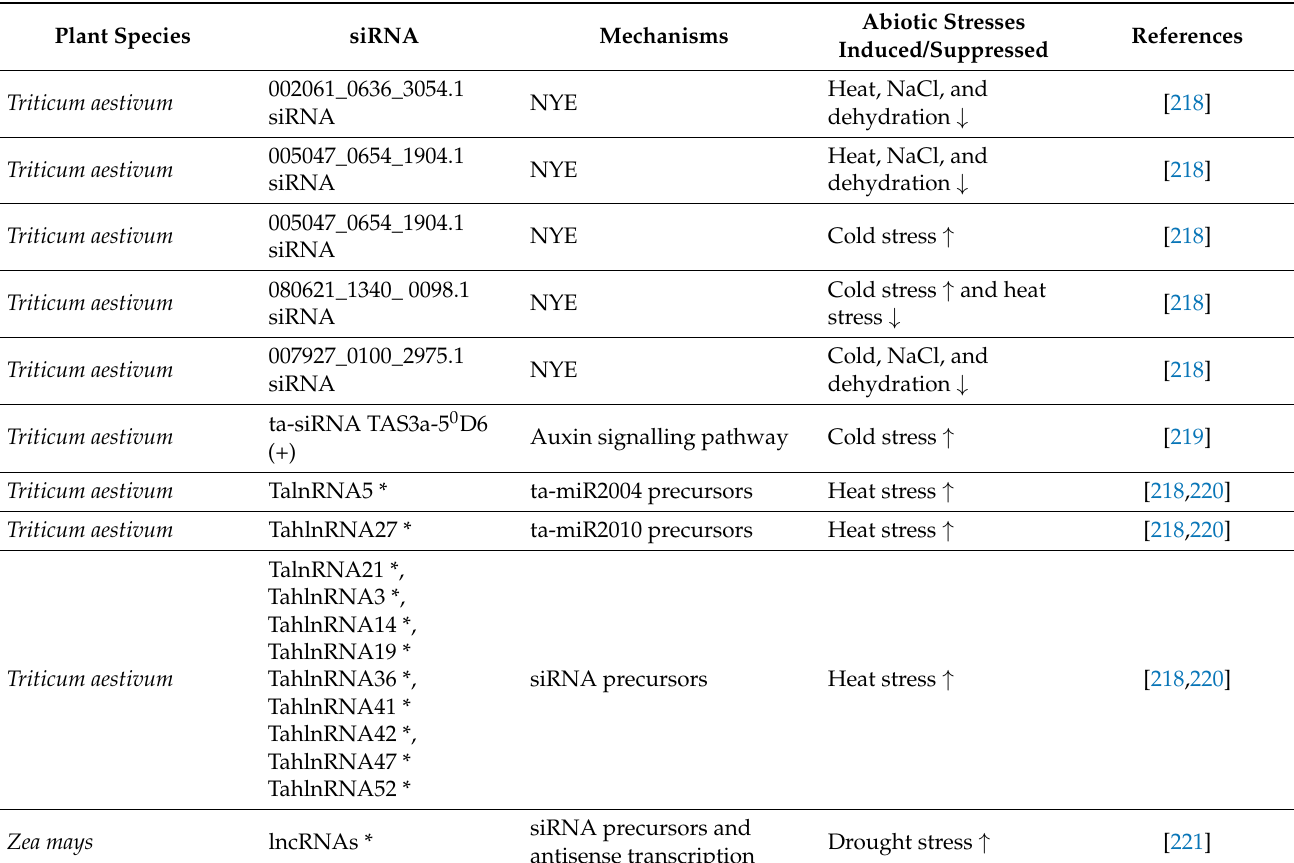
Star symbol “*” indicates lncRNA; no symbol indicates siRNA. Up arrow “ ↑ ” indicates that siRANs/lncRNAs are enhanced in response to the corresponding abiotic stress while the down arrow “ ↓ ” indicates that siRANs/lncRNAs are suppressed in response to the corresponding abiotic stress. NYE indicates that the mechanism/process of that particular siRNA or lncRNA has not yet been established. RdDM, small RNA-directed DNA